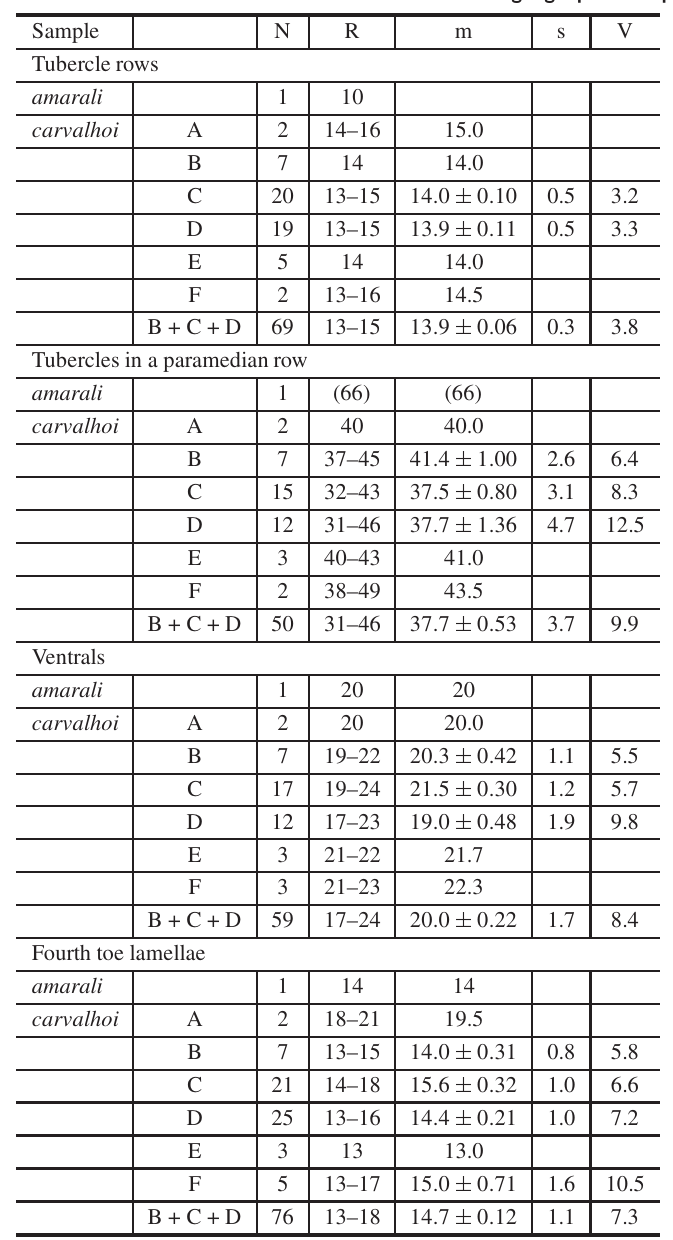
Gymnodactylus amarali and carvalhoi , statistics of the distributions of frequencies, meristic characters. See text for definitions of carvalhoi geographic samples.